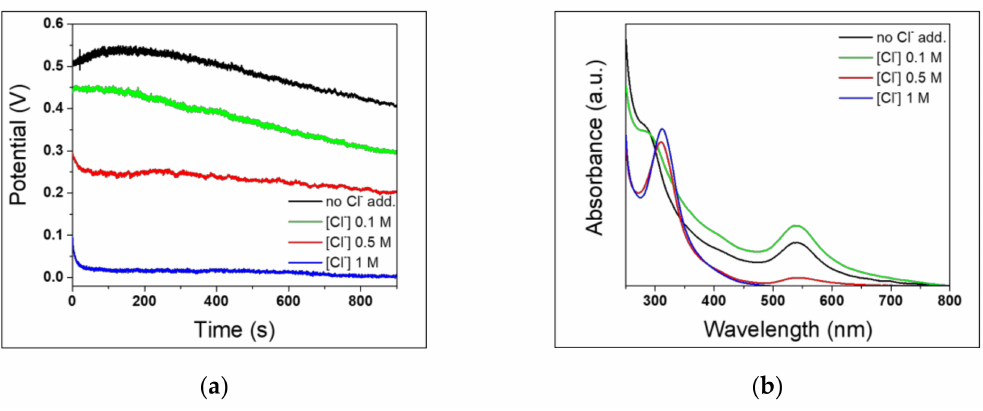
Figure 8. AuNPs synthesized with AISI 430 with di ff erent [Cl − ]. ( a ) OCP measurements; ( b ) UV-Vis